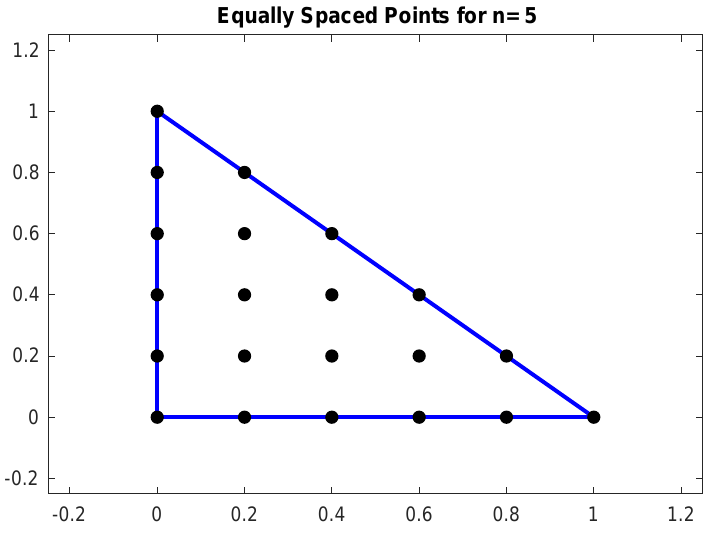
Figure 4. Equally Spaced Points in a